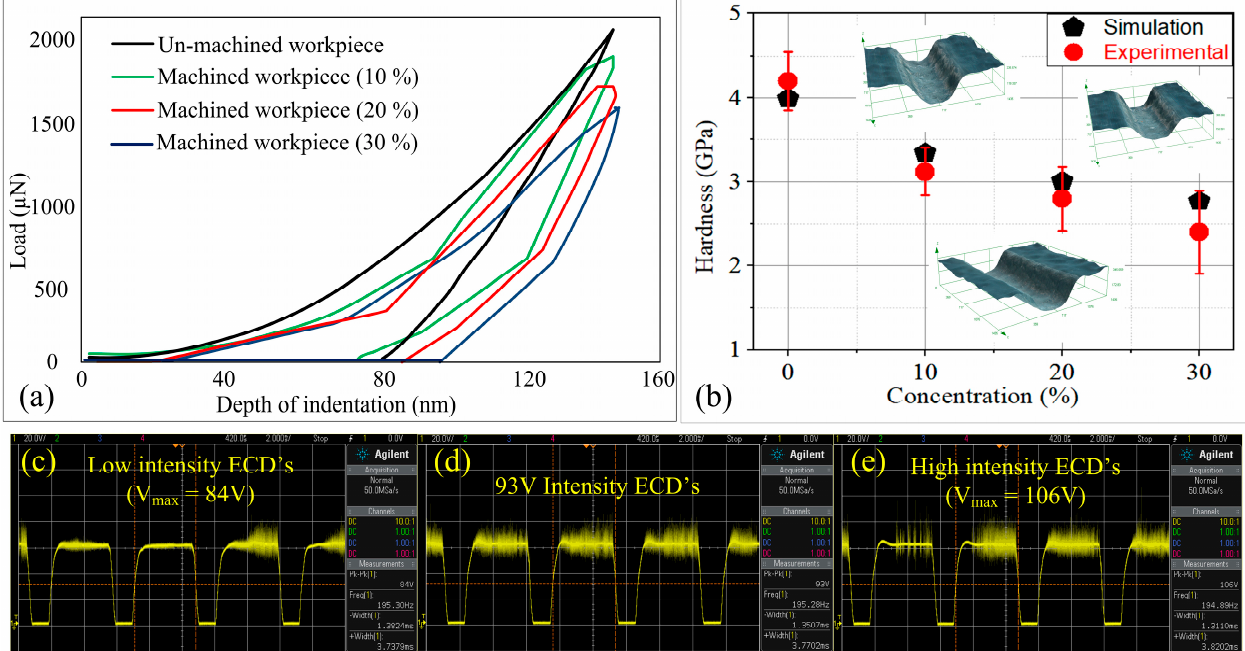
Figure 8. ( a ) Load–displacement curves obtained from simulation results, ( b ) comparison between simulation and experimental results; discharge signals obtained at ( c ) 10%, ( d ) 20%, and ( e ) 30% electrolyte concentration.